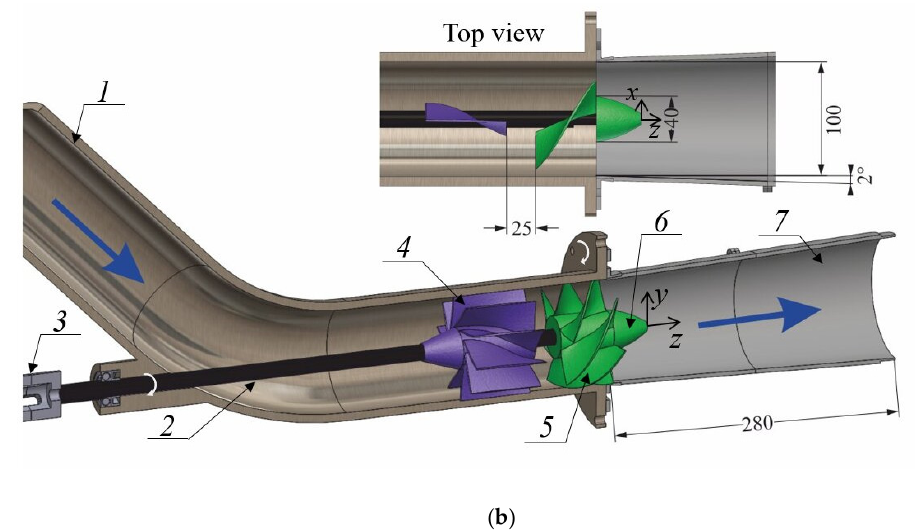
Figure 1. Air model of a micro hydraulic turbine: ( a ) Diagram of the experiment system; ( b ) Detailed diagram. 1—inlet pipe, 2—shaft, 3—servo drive, 4—guide vane (stationary swirler), 5—runner (rotating swirler), 6—streamline body, 7—conical draft tube, 8—nozzle, 9—wind tunnel.